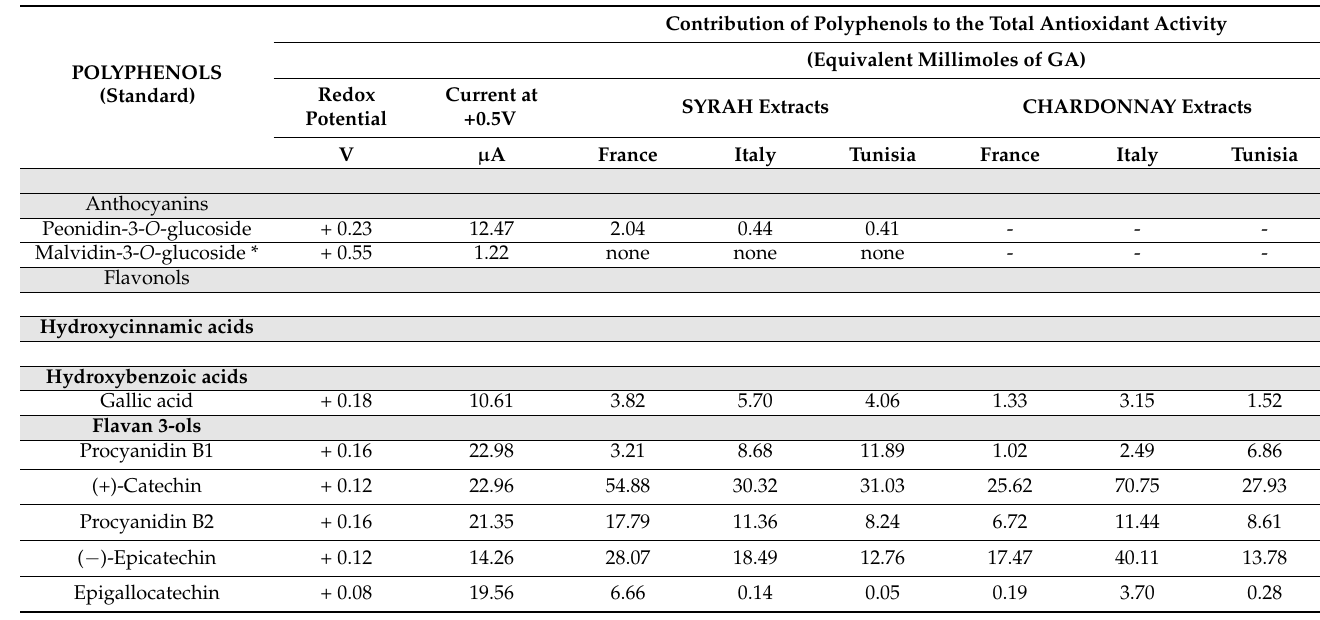
Table 2. Contribution of main polyphenols to the total antioxidant activity of pomace extracts.